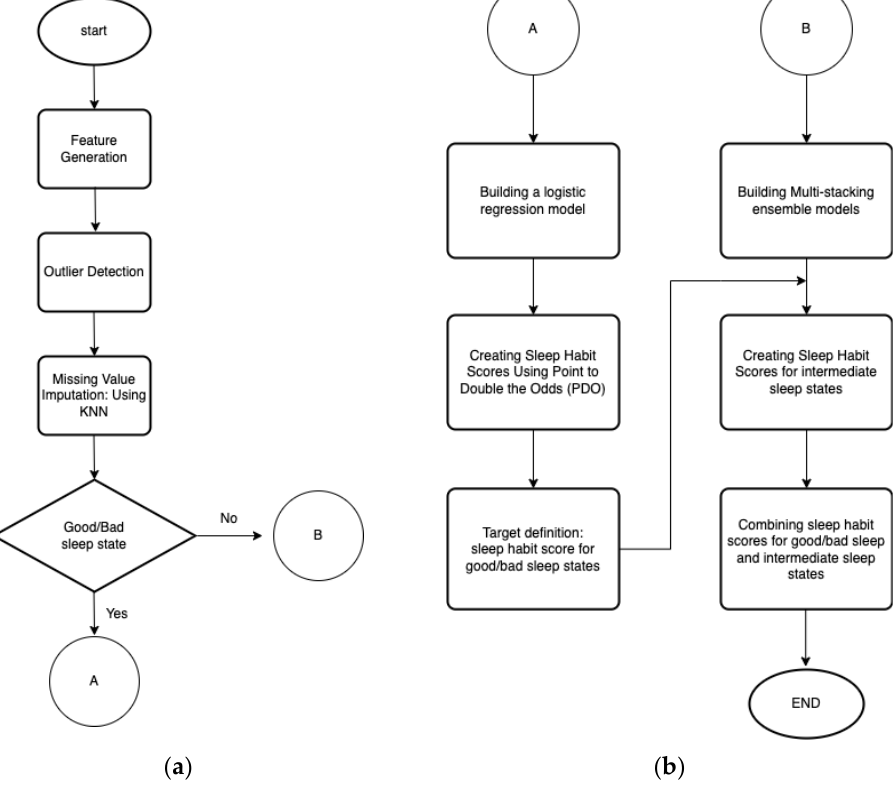
Figure 1. ( a ) Summary flowchart; ( b ) specific sleep score creation process.